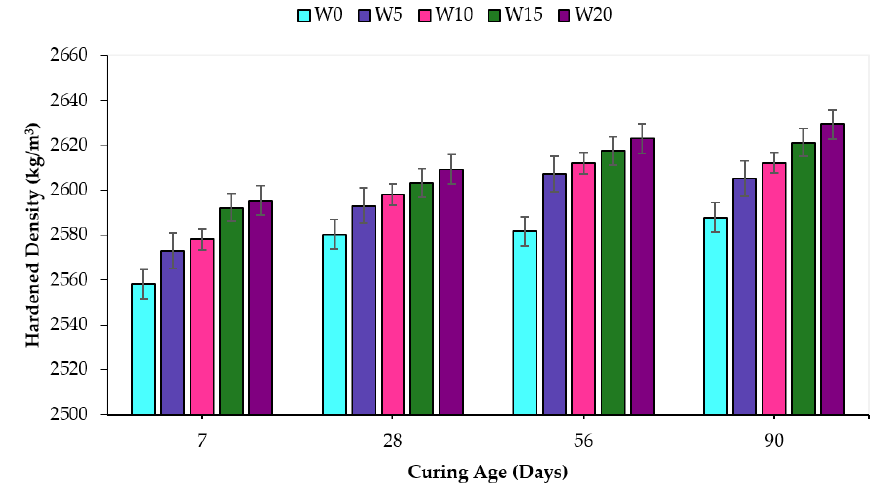
Figure 10. Hardened concrete density containing WSA at varying curing ages.